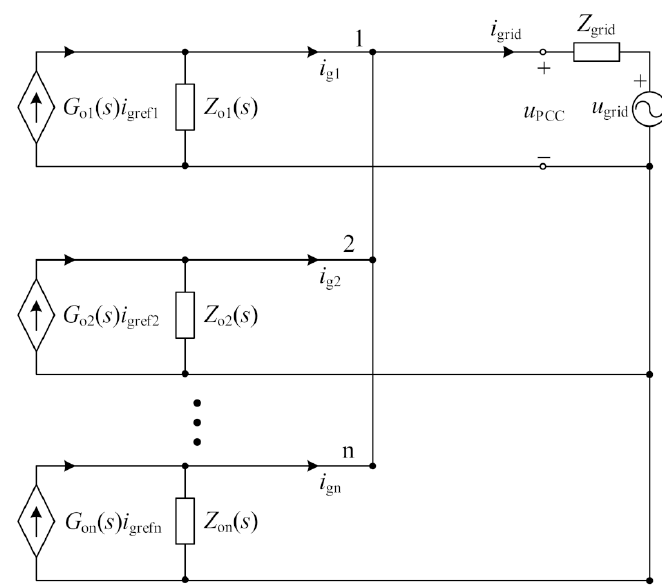
Figure 11. Impedance structure of converter cluster